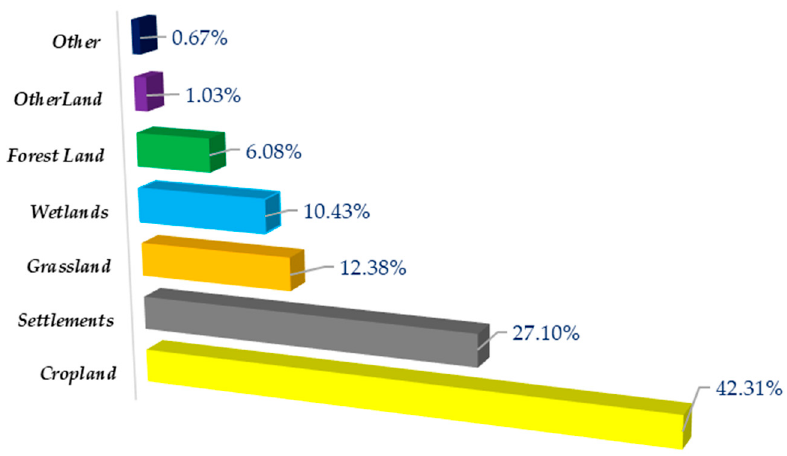
Figure 4. LULUCF GHG emissions structure by land use categories for the 1990–2019 time period, EU-27 + UK. Table 3. LULUCF GHG removals structure by land use categories during 1990–2019, EU-27 + UK. Year CO 2 Removals 1990 (kt CO 2